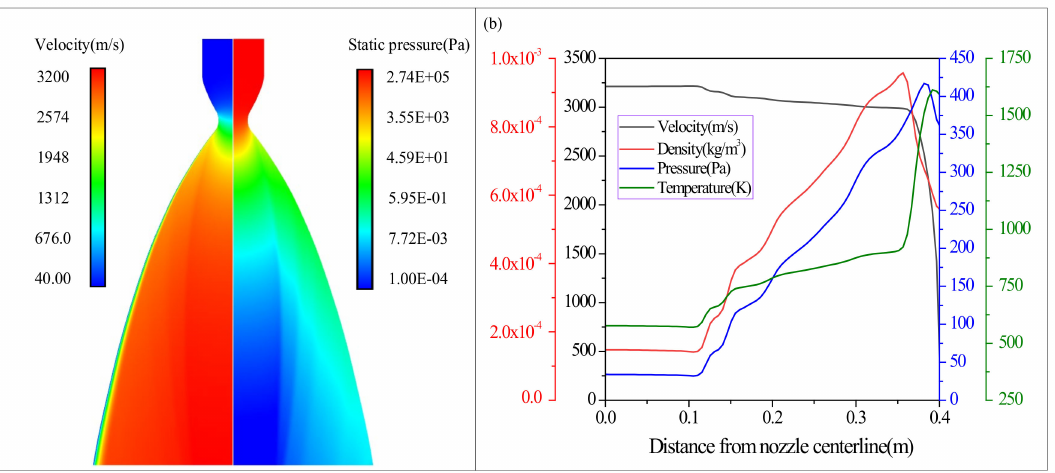
Figure 3. The nozzle flow properties: ( a ) nozzle internal flow contour of velocity (left) and static pressure (right) and ( b ) nozzle exit plane flow